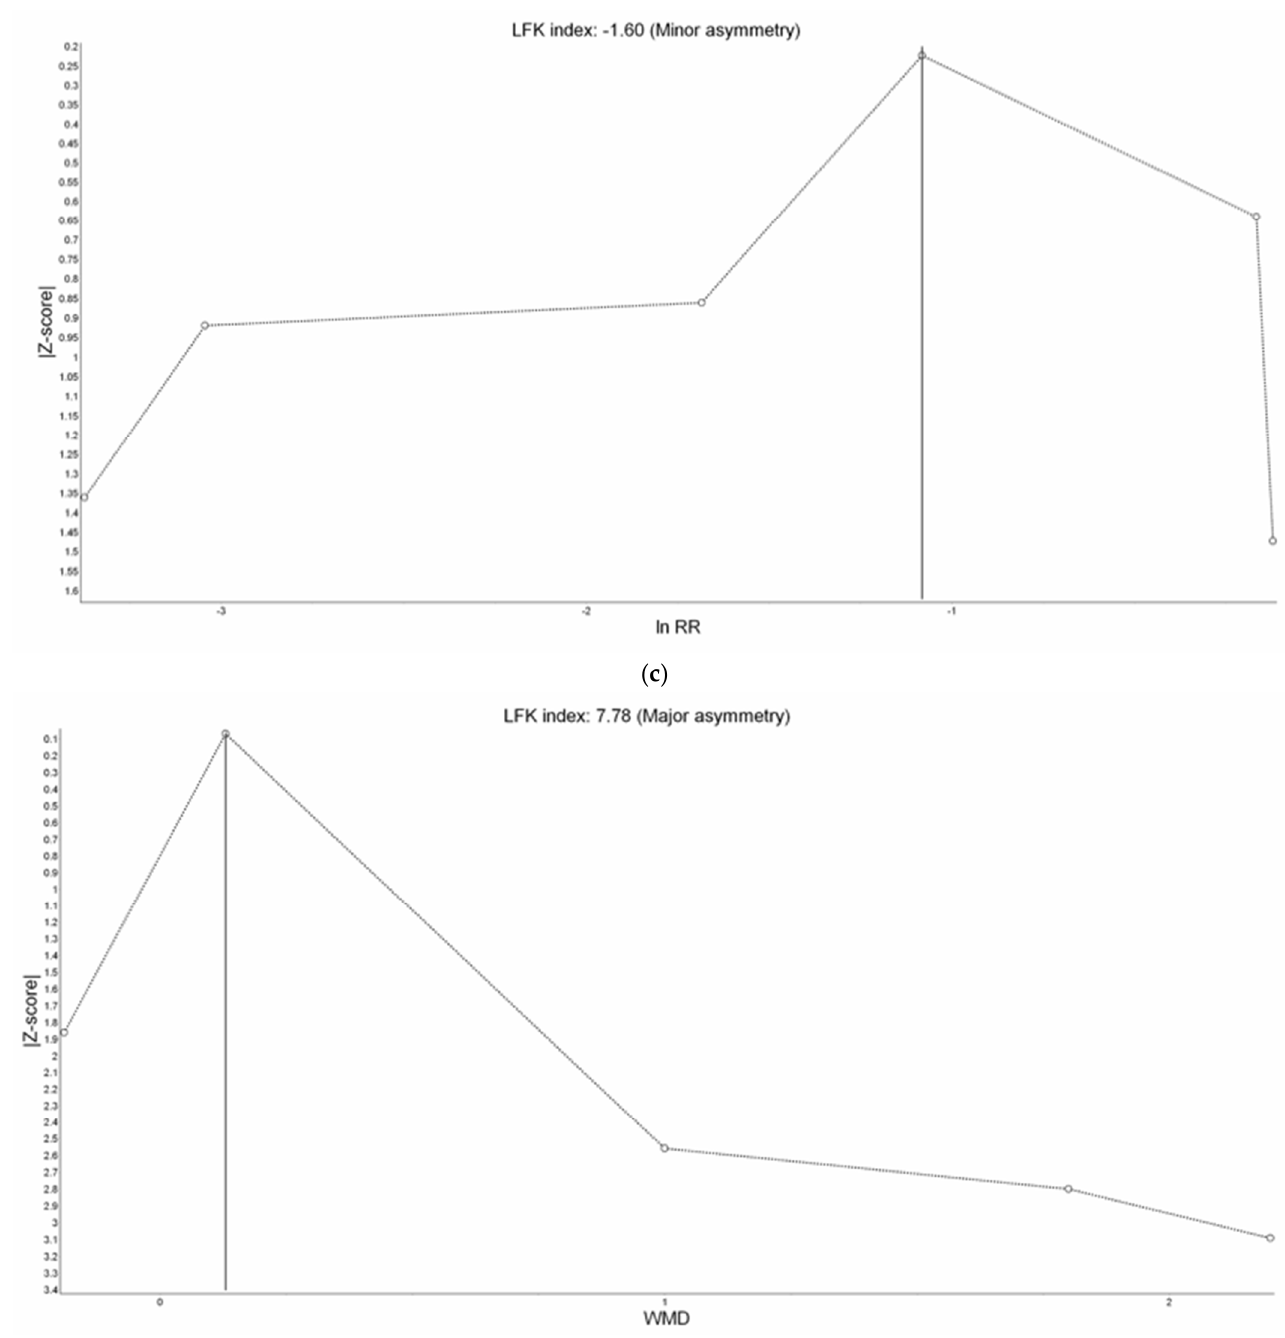
Figure A1. Doi Plot of study outcomes. ( a ) Incidence of hypoxemia, ( b ) incidence of severe hypox- emia, ( c ) need for minor airway interventions, and ( d ) duration of procedure.